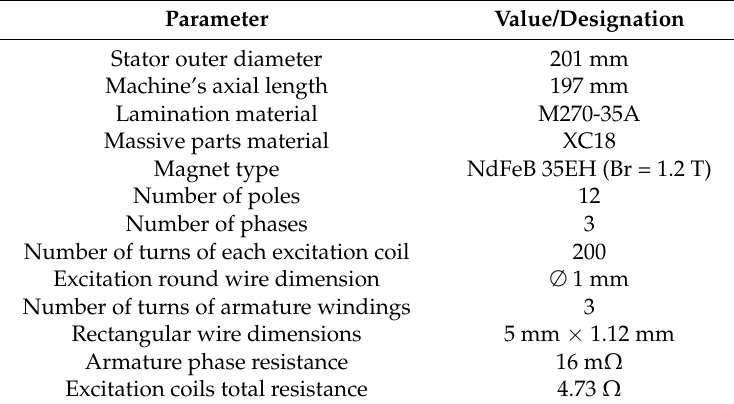
Table 3. Double excitation synchronous machine data.